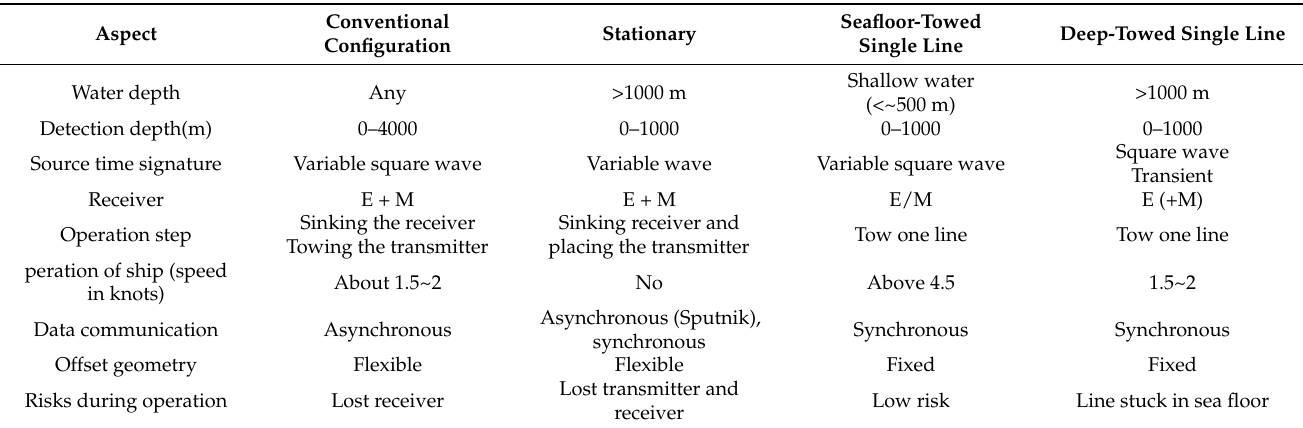
Table 1. Overview of acquisition